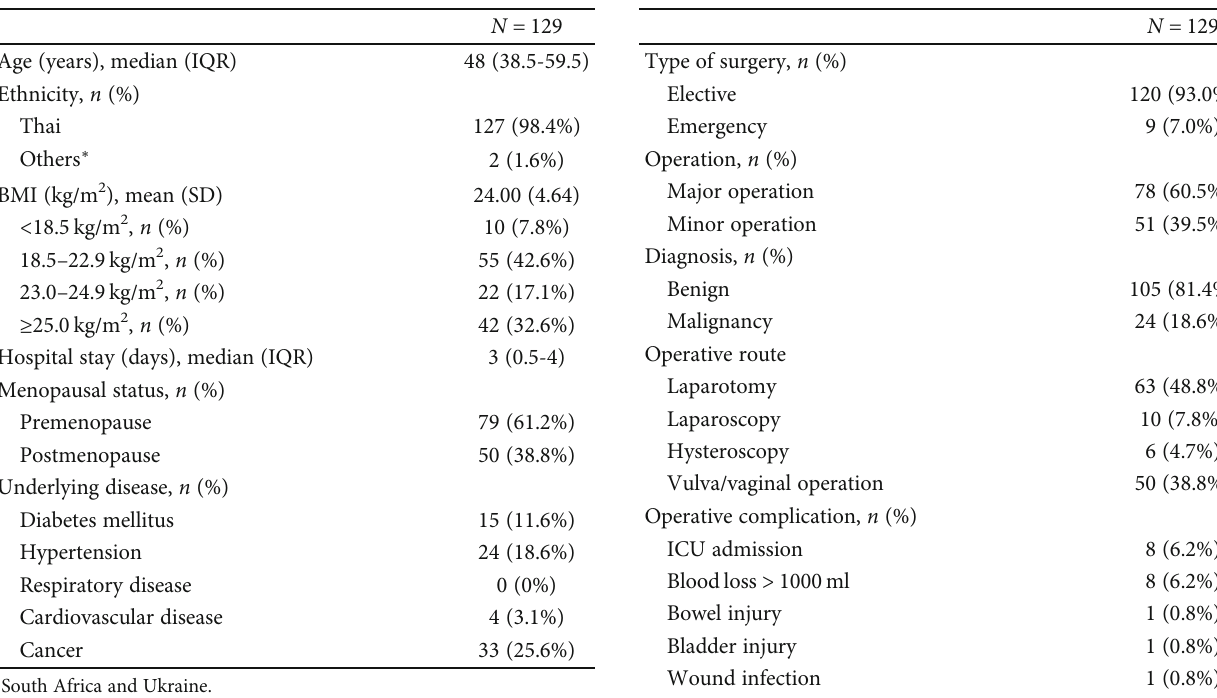
Table 3: Operative